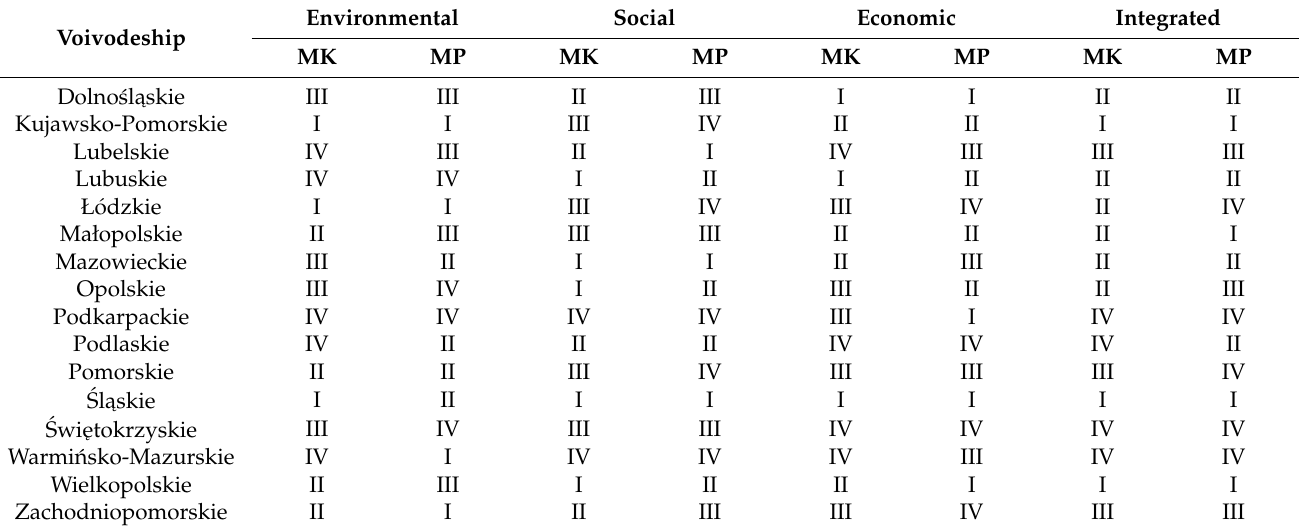
Table 6. Groups of similar voivodeships according to particular orders for analyzed voivodeships.